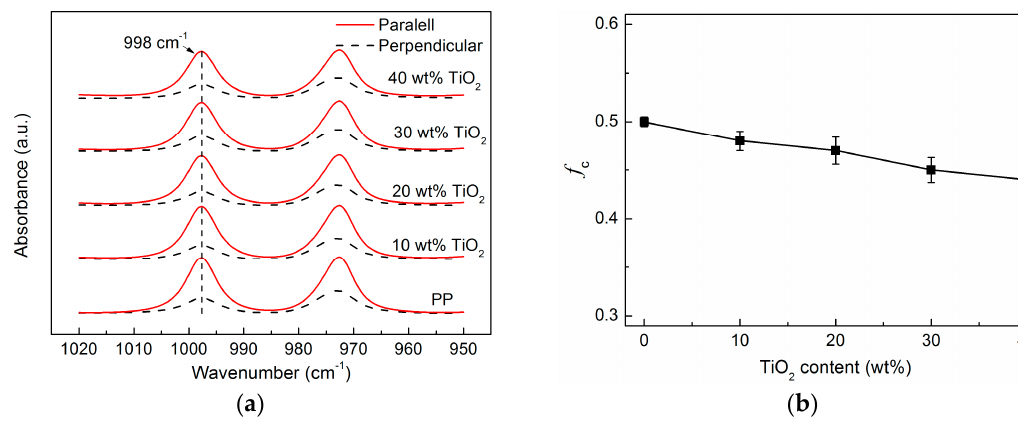
Figure 3. ( a ) Polarized IR spectra for the PP and PP/TiO 2 composite films in the range of 1020 to 950 cm − 1 . ( b ) Crystalline orientation (f c ) of PP as function of TiO 2 content.